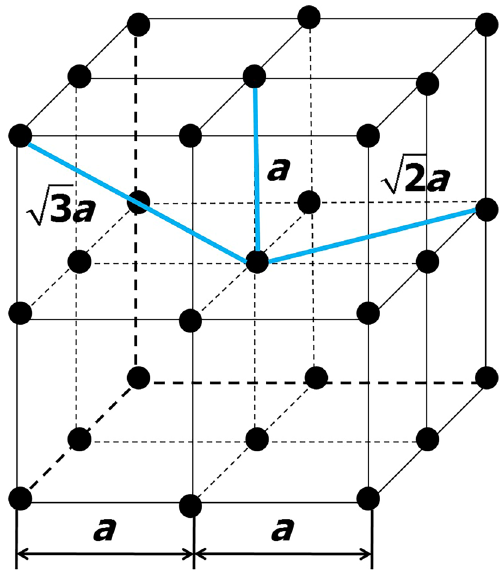
Figure 1. A fragment of 3-D simple cubic lattice showing three possible types of links between pairs of neighboring nodes. Each node can potentially be a source of 6, 12, and 8 links with the lengths of a , √ 2 a , and √ 3 a , respectively.